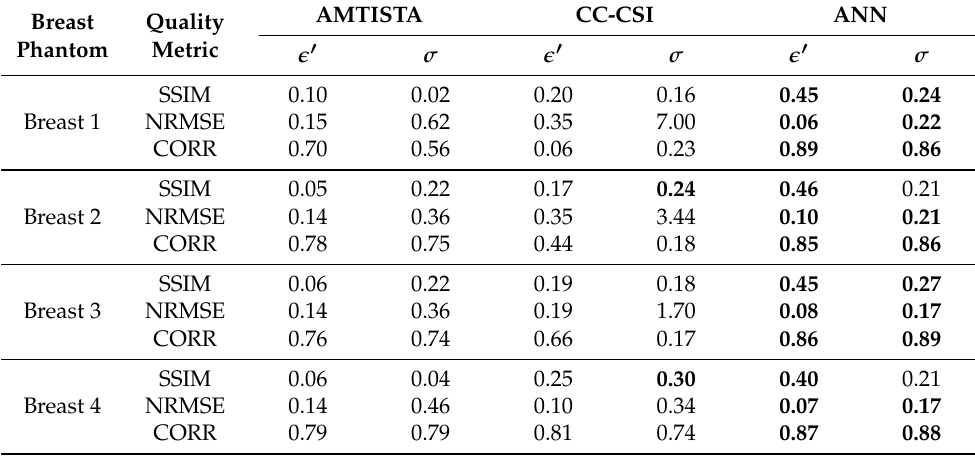
Table 4. Quality metrics for both permittivity and conductivity retrieved maps of Figures 6 and 7. The bold quantities refer to the best value per row, identifying the approach which provides the best recovery according to the considered